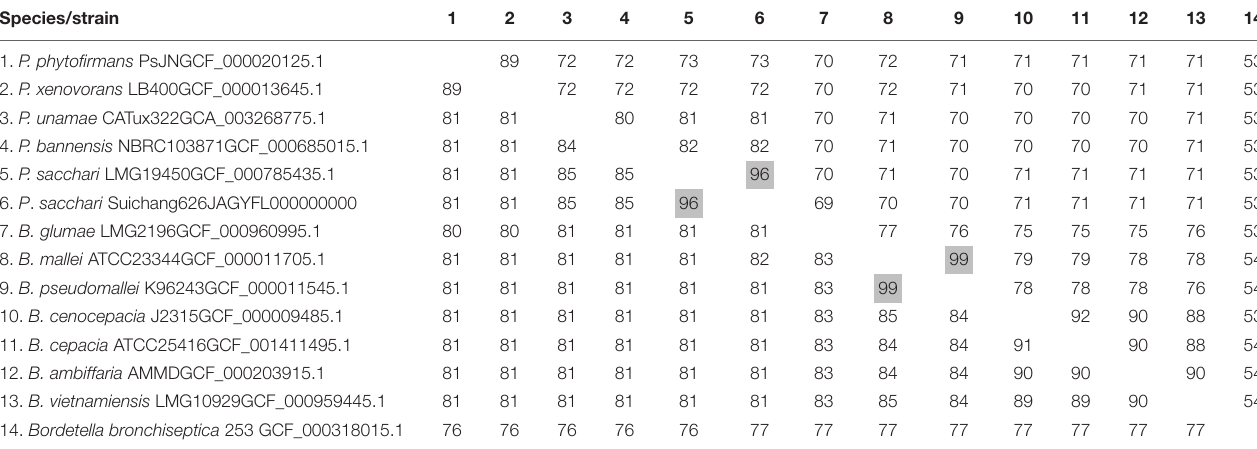
TABLE 2 | Average amino acid identity (AAI) and average nucleotide identity (ANI) values of selected Paraburkholderia and Burkholderia genomes. Species/strain